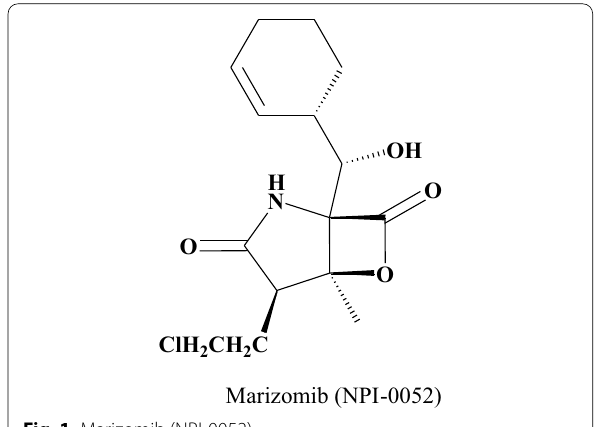
Fig. 1 Marizomib